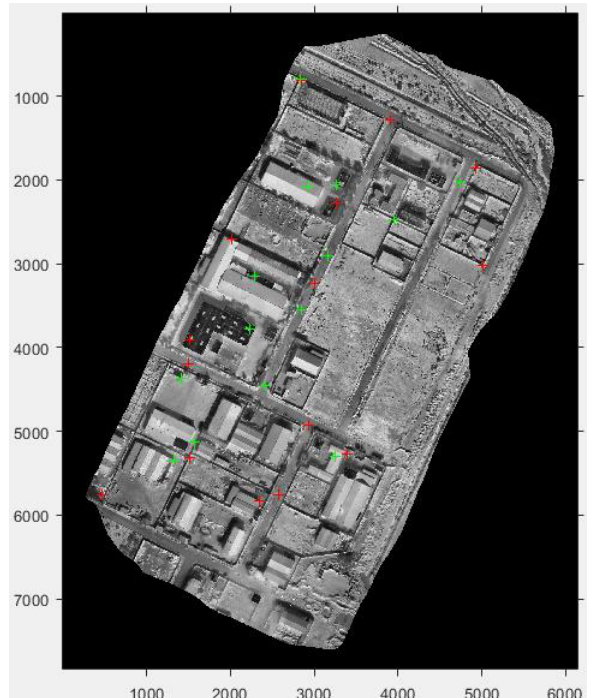
Figure 6. Generated ortho thermal image and the position of control (red) and check (green) points in the study